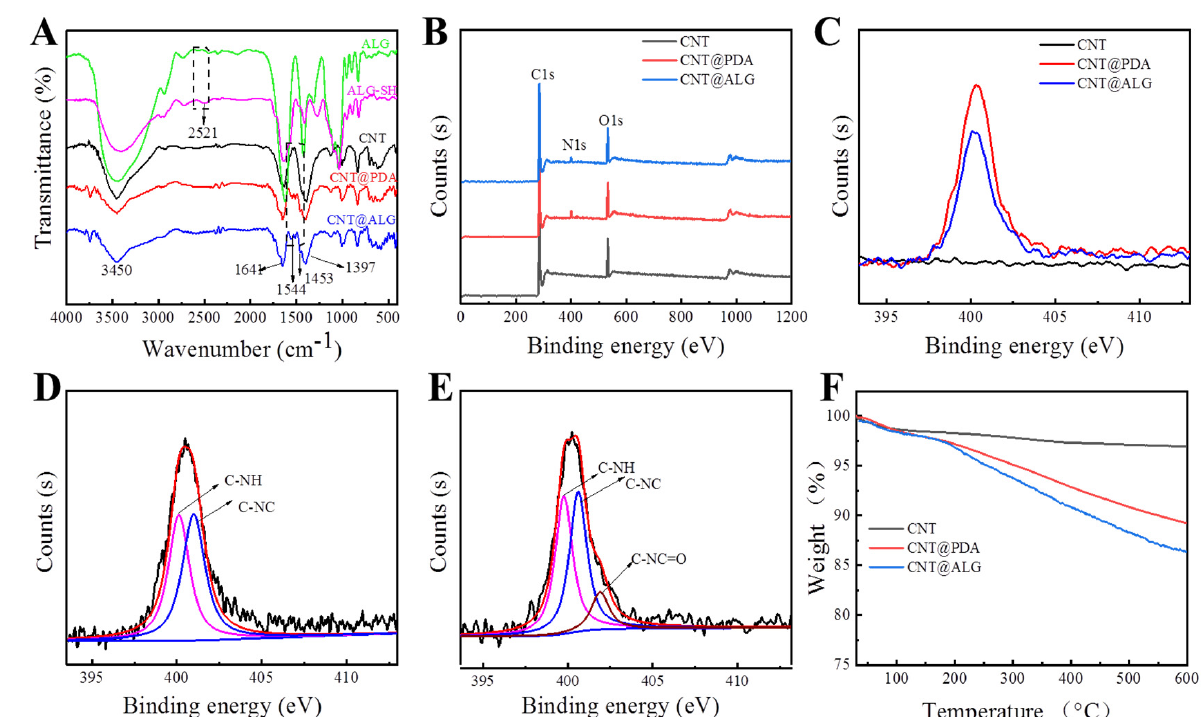
Figure 2. ( A ) FTIR spectra of ALG, ALGSH, CNT, CNT@PDA, CNT@ALG; ( B ) XPS spectra of CNT, CNT@PDA, CNT@ALG; ( C ) XPS spectra of N1s of CNT, CNT@PDA, CNT@ALG; ( D ) High-resolution XPS spectra of N1s of CNT@PDA; ( E ) High-resolution XPS spectra of N 1s of CNT@ALG; ( F ) TGA curves.